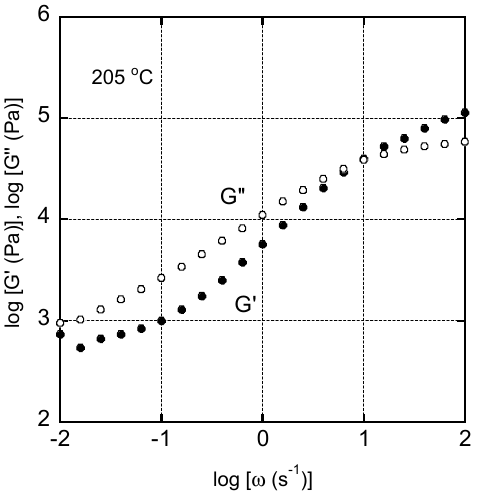
Figure 4. Angular frequency dependencies of shear storage modulus G ’ and loss modulus G ” of CA/TEC (60/40) at 205 °C.